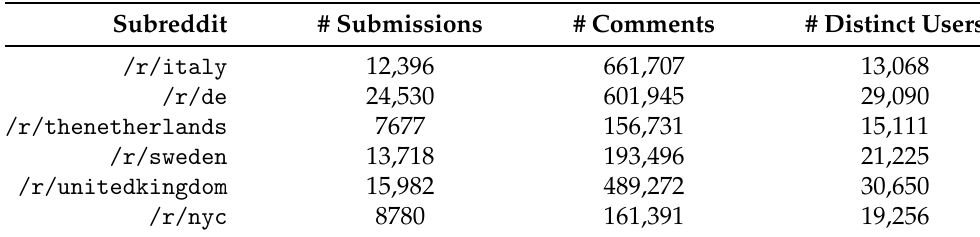
Table 3. Total number of submissions, comments and distinct users for each subreddit in 2019 (in the following, 2019 dataset or non-COVID